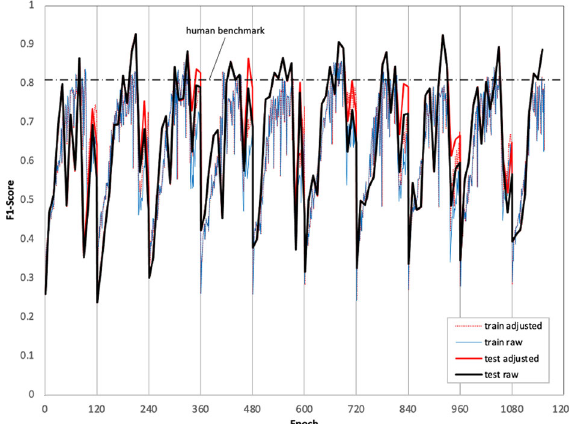
Fig. 4 Ensemble model F1-scores during training. F1-Scores evaluated on the training and test sets during tenfold cross- validation training (note that the training was terminated due to a power outage on the last fold after 75 epochs).